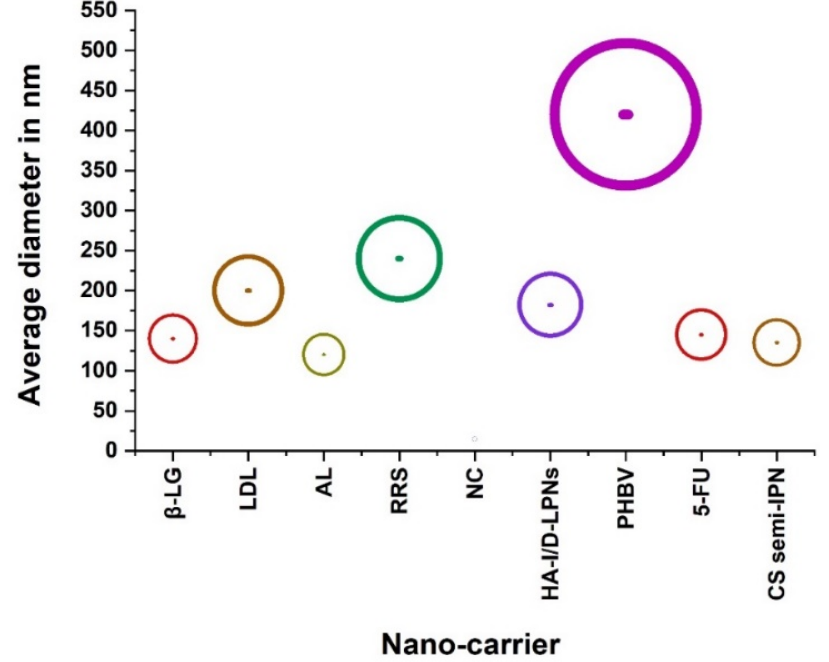
Figure 4. average diameters of nano-carrier therapy. Figure 4. Average diameters of nano-carrier therapy.